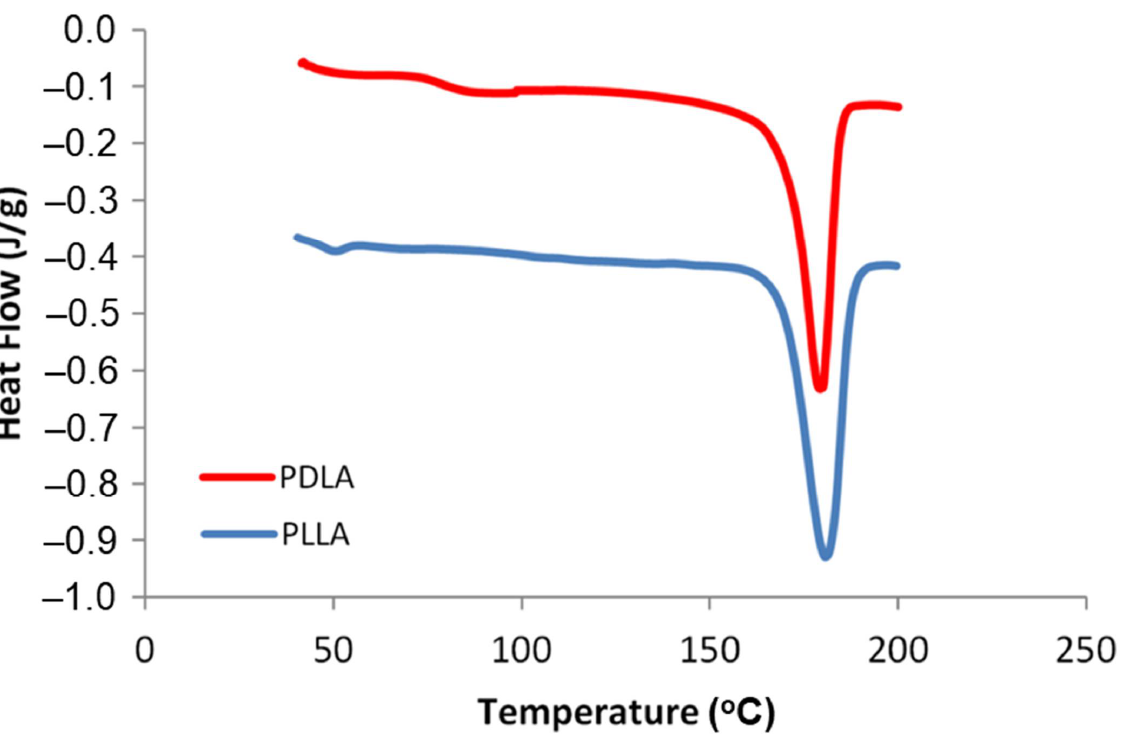
Figure 1. The DSC thermograms of PLLA and PDLA homopolymers produced by ring-opening bulk polymerization at 130 °C for 24 h.